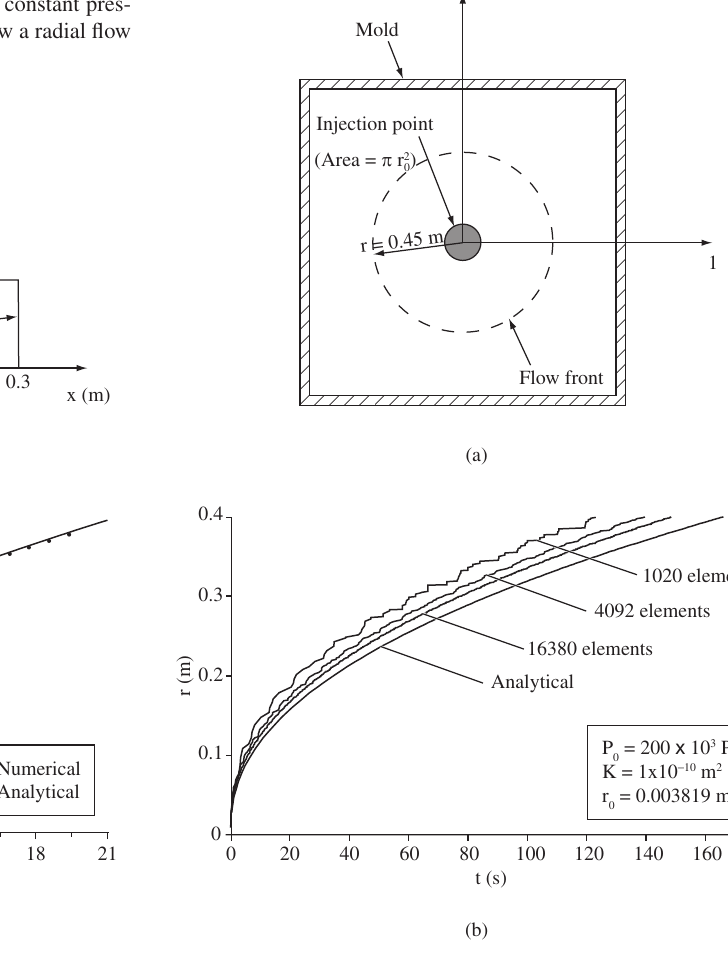
Figure 6. Point injection (radial) from the center of a square mold: a) Problem sketch, and b) Analytical and numerical solution